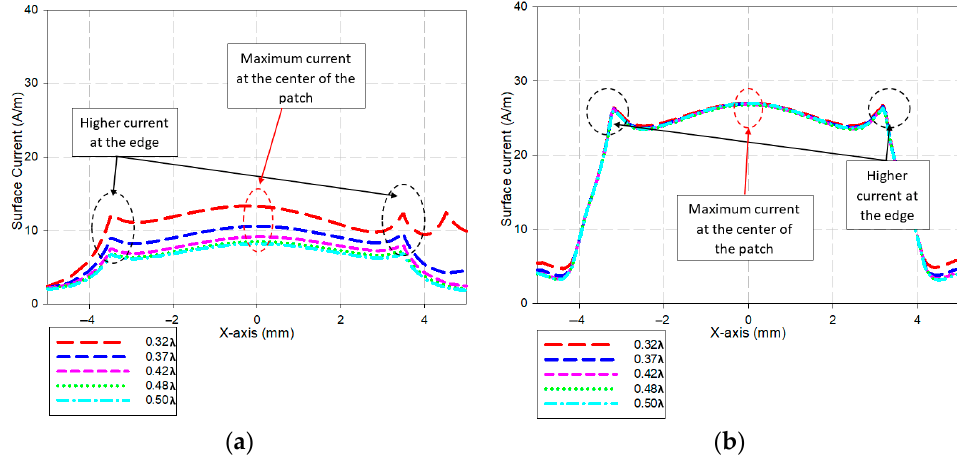
Figure 9. Current distribution for ( a ) Antenna 1 and ( b ) Antenna 2.